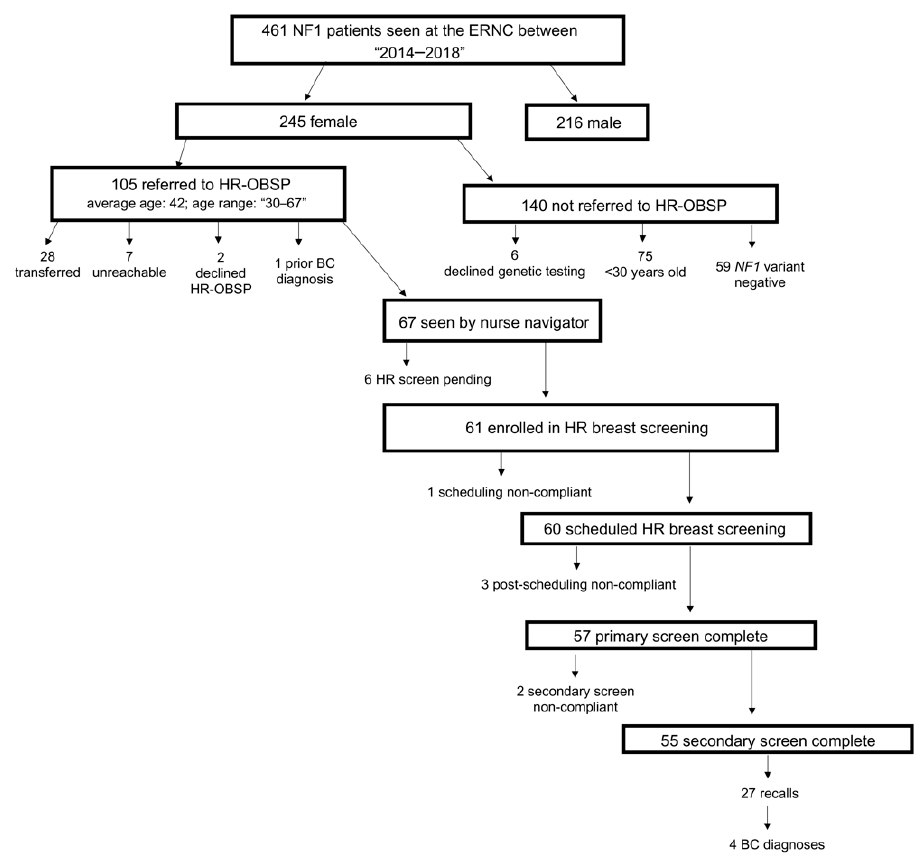
Figure 1. NF1 patient flow chart. NF1: Neurofibromatosis Type I; ERNC: Elizabeth Raab Neurofibromatosis Centre; HR-OBSP: High-Risk Ontario Breast Screening Program; BC: Breast Cancer.